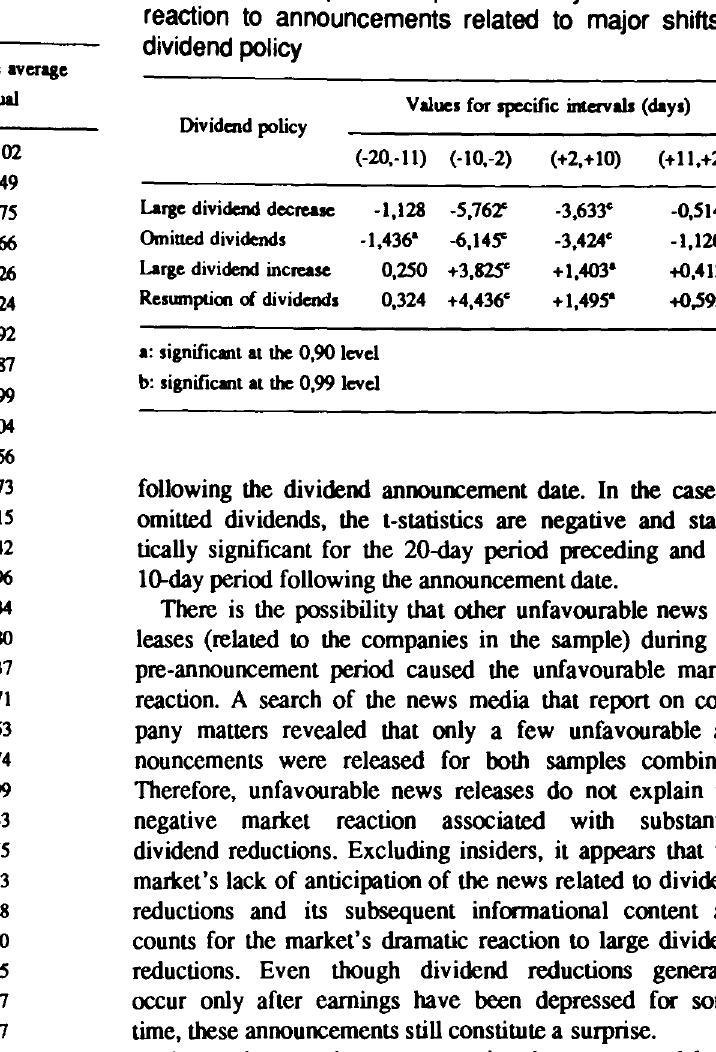
Comparative period analysis of market reaction to announcements related to major shifts